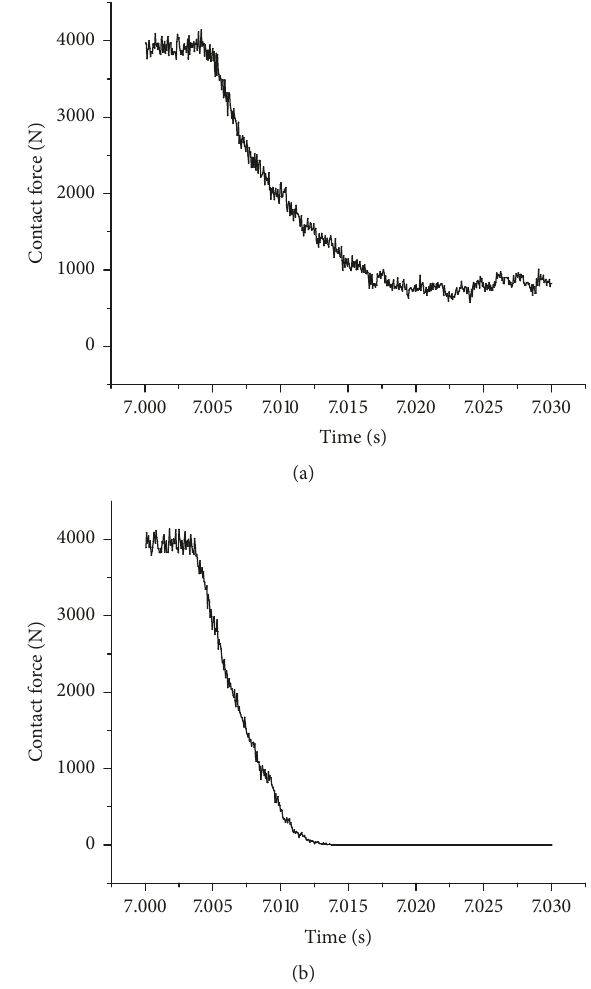
Figure 10: Normal contact force of tire-pavement model during hydroplaning simulation: (a) 70km/h; (b) 90